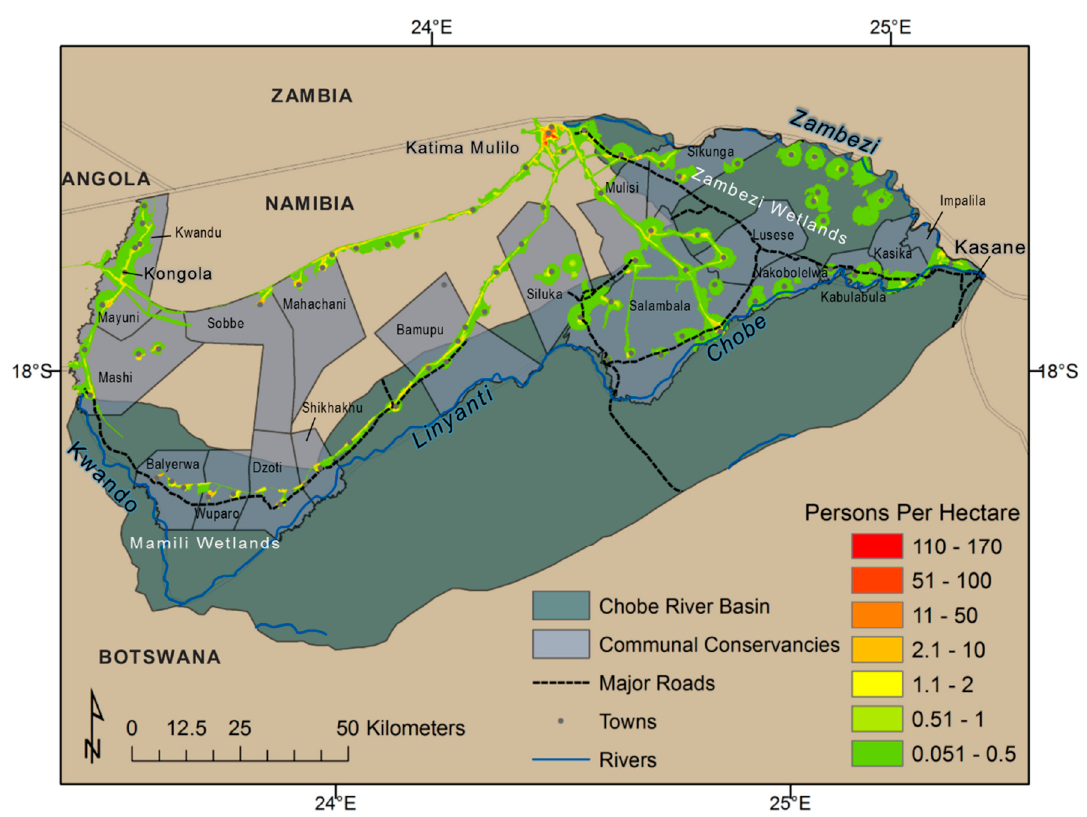
Figure 13. Distribution of population in the Zambezi Region of eastern Namibia.